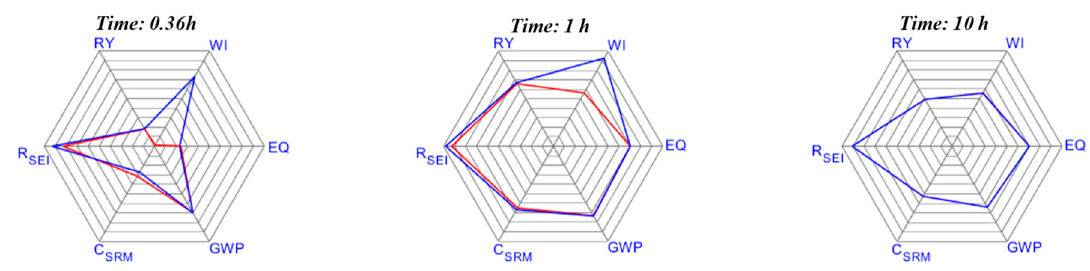
Figure 15. Case 2—comparison between control without WI constraint (red line) and control with WI constraint (blue line) at three representative sample points.